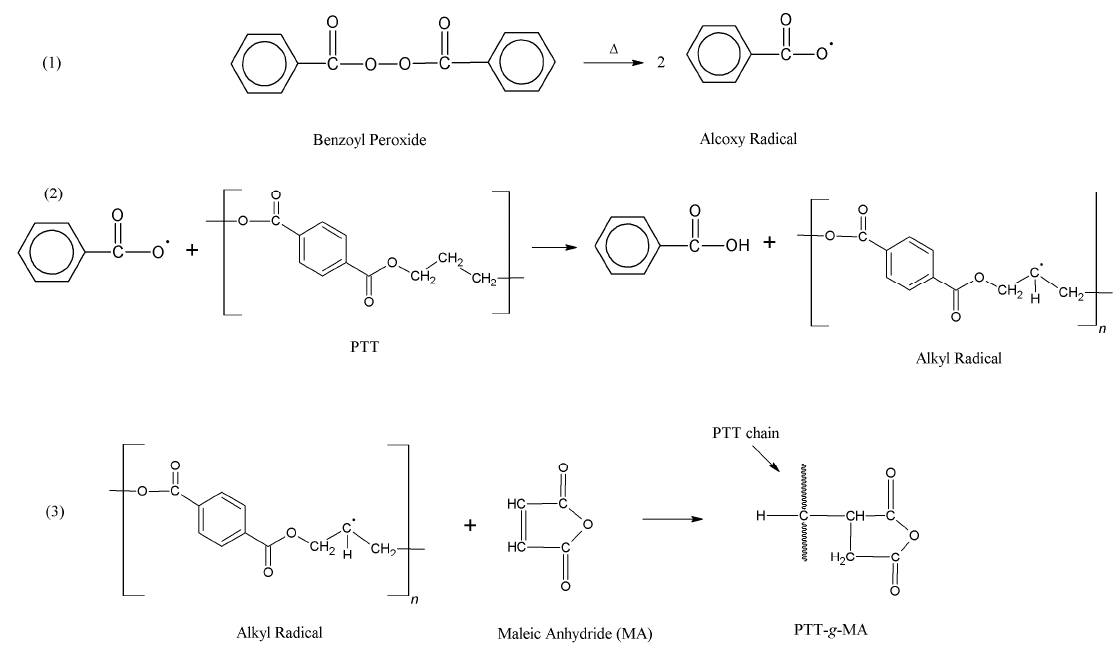
Figure 1. Reaction mechanism of maleic anhydride (MA) in poly(trimethylene terephthalate) (PTT) chains in the presence of benzoyl peroxide (BPO). PTT- g -MA: MA grafted with PTT.